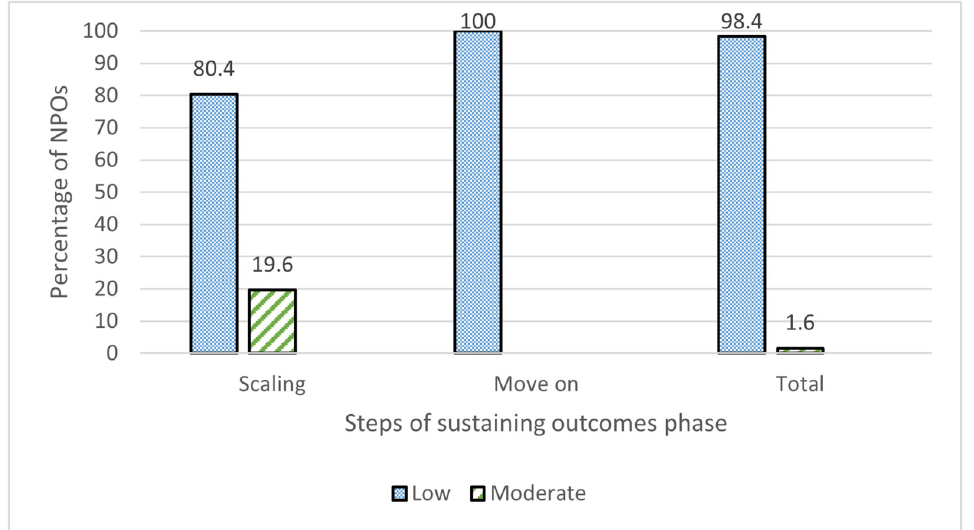
Fig 5. Nonprofit organizations’ implementation levels for the sustaining outcome